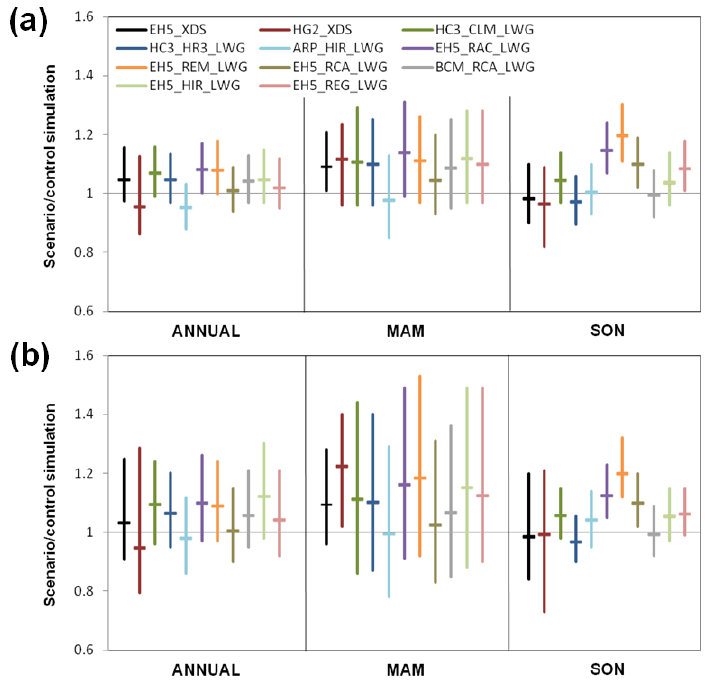
Fig. 7. Ratio between scenario (2071–2100) and reference (1971–2000) simulations for (a) 5-yr return value and (b) 20-yr return value. Vertical lines indicate 90% bootstrap confidence interval. The results are statistically significant when the ratio of 1.0 lies outside the 90% confidence interval. 24-h precipitation events averaged over the Lech catchment are shown.